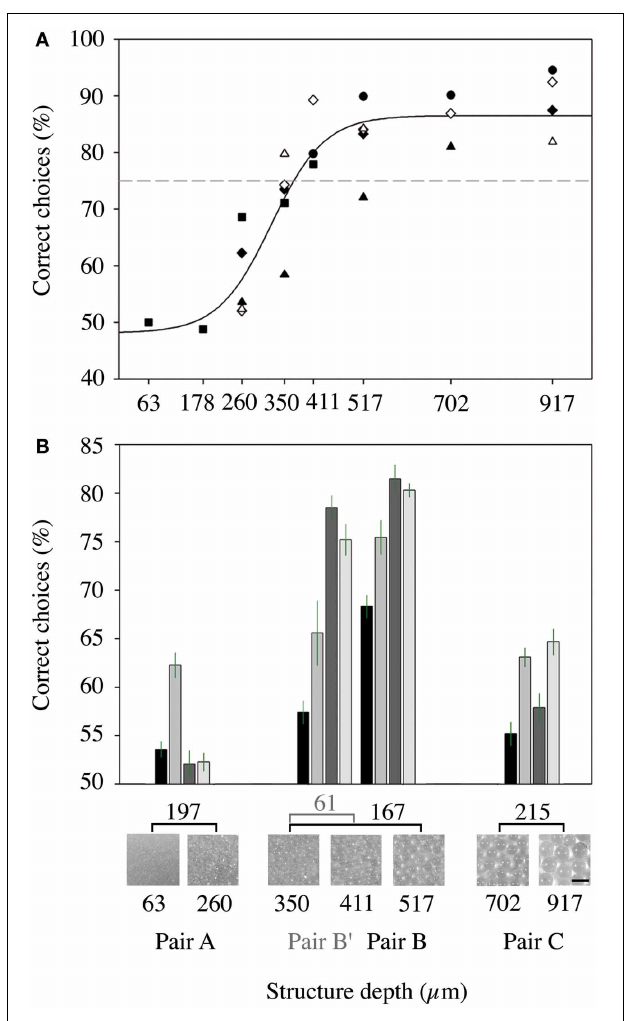
FIGURE 4 | Results of the behavioral experiments with Glossophaga soricina. (A) Psychometric function of the ability of six bats to discriminate between targets with different structure depth (experiment I). The results of the different bats are marked by different symbols. The x-axis gives the structure depth of the unrewarded target, while we always trained on the target with the 63 μ m structure. The dashed line marks the 75% threshold. (B) Results of experiment II. Mean percentages of correct choices for discrimination of selected pairs of targets. Each pair was presented to each of the four bats for two nights. The error bars indicate the standard error. X-Axis: upper line: difference of structure depth of the respective pair. Middle line: magnified images of the structured targets. Two bottom lines: structure depth of the targets in μ m and name of the respective pair.